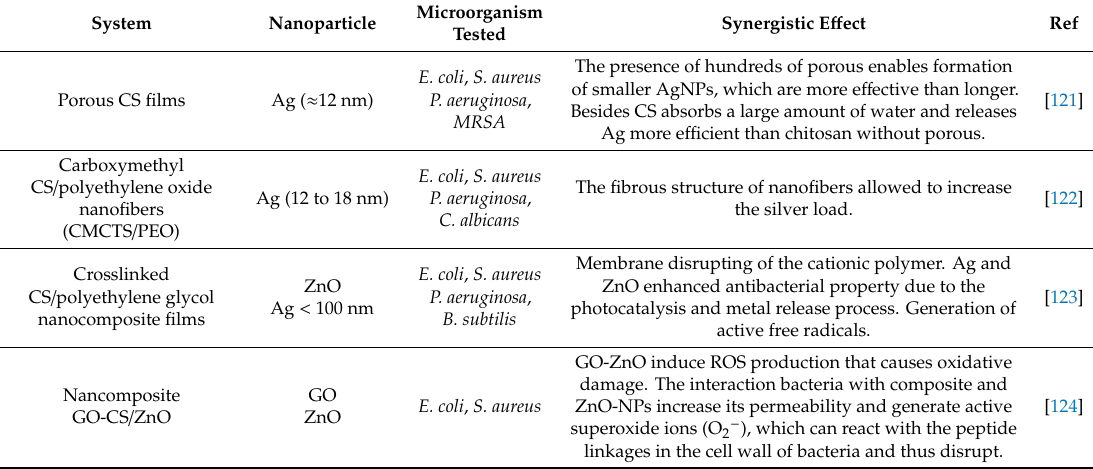
Table 3. Supportive antimicrobial systems based in chitosan and biocidal NPs.